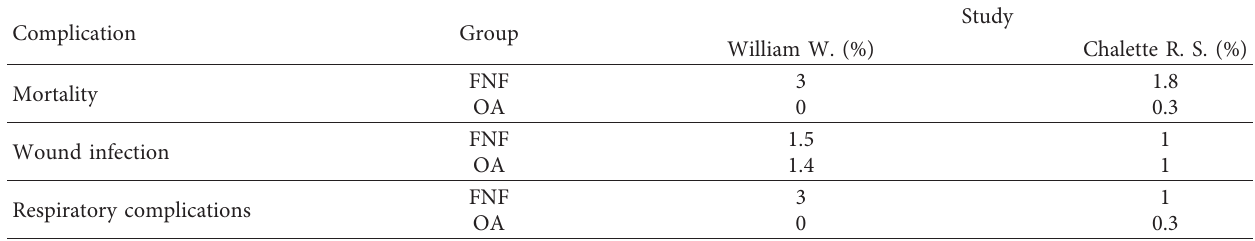
Table 4: Selected complications’